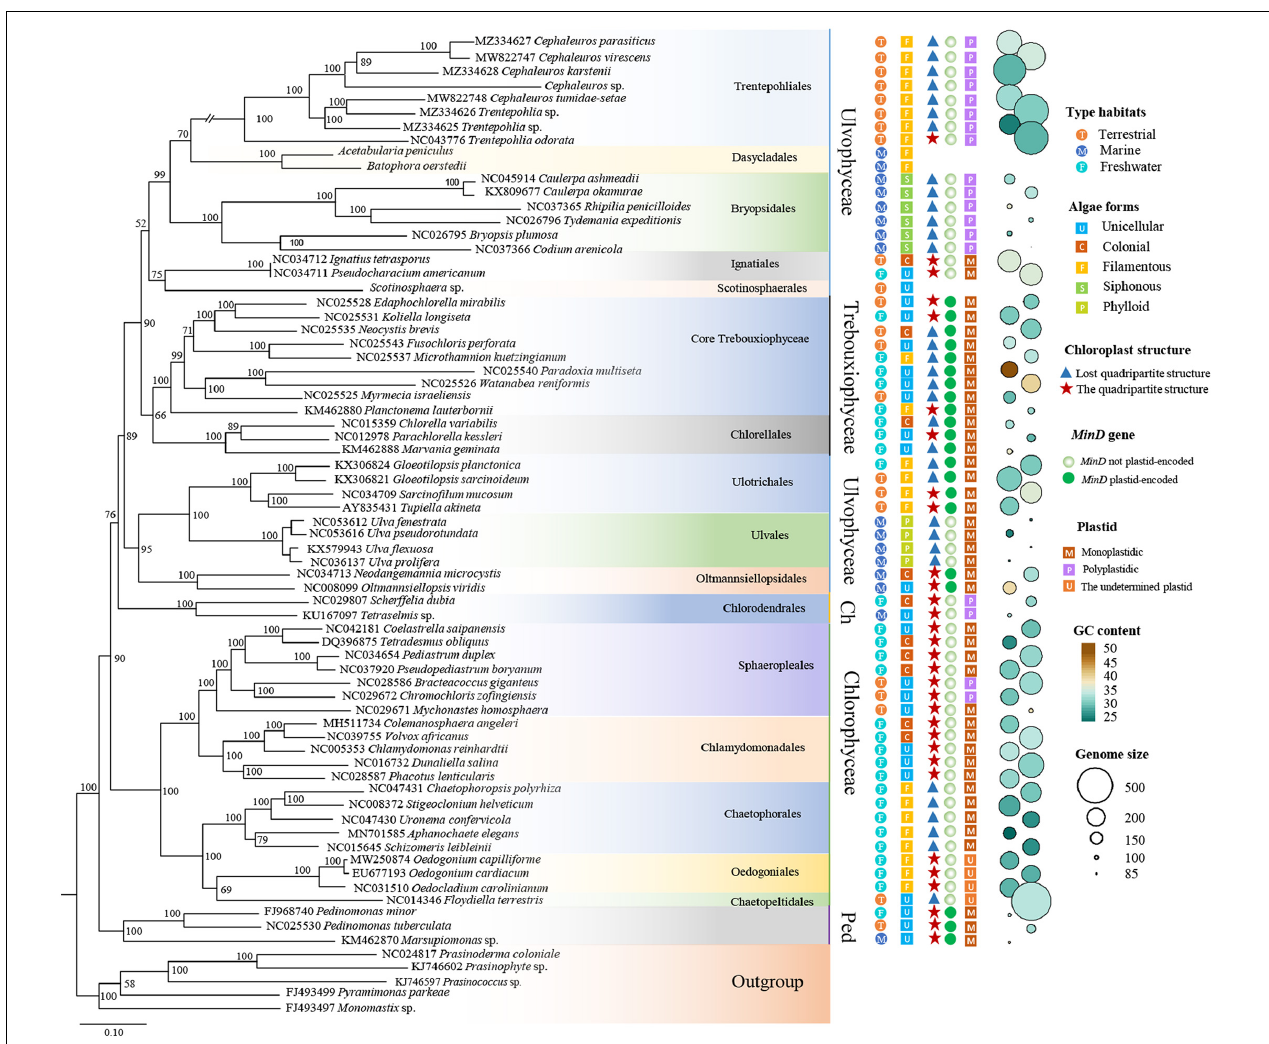
FIGURE 5 | ML phylogenetic tree inferred from 31 common protein coding genes. Maximum likelihood bootstrap values (1,000 replicates) are given near the nodes. Scale bar indicates substitutions per site. Chlorodendrophyceae and Pedinophyceae represented by the abbreviations Ch and Ped, respectively. On the right of the figure, from left to right, the first column of circles with different colors indicates that the algae strains come from different habitats. The second column of squares with different colors represents different morphology of green algae. The triangles in the third column represent that algae strains lack quadripartite structure, the pentacles represent algae strains have quadripartite structure. The fourth column represents whether the minD gene is present in chlorophytes algae. The five column represents the number of plastids per cell. The size and color of the circle on the right of the graph represent the genome size and GC content,